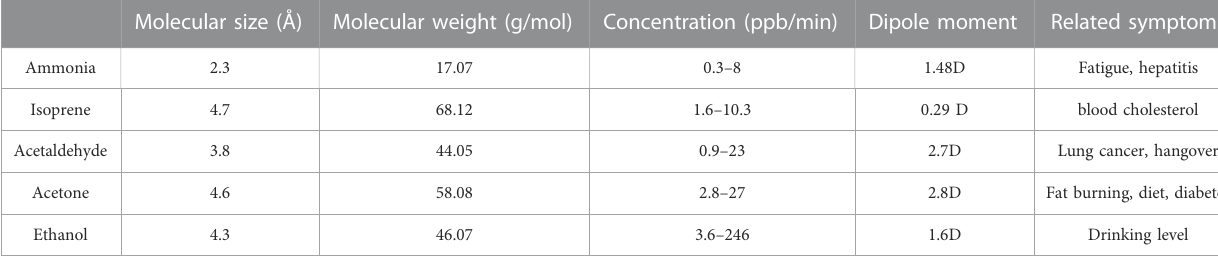
TABLE 2 Summary of typical VOCs and their related symptoms (Menezes et al., 2013; Belizario et al., 2021). Molecular size (Å) Molecular weight (g/mol) Concentration